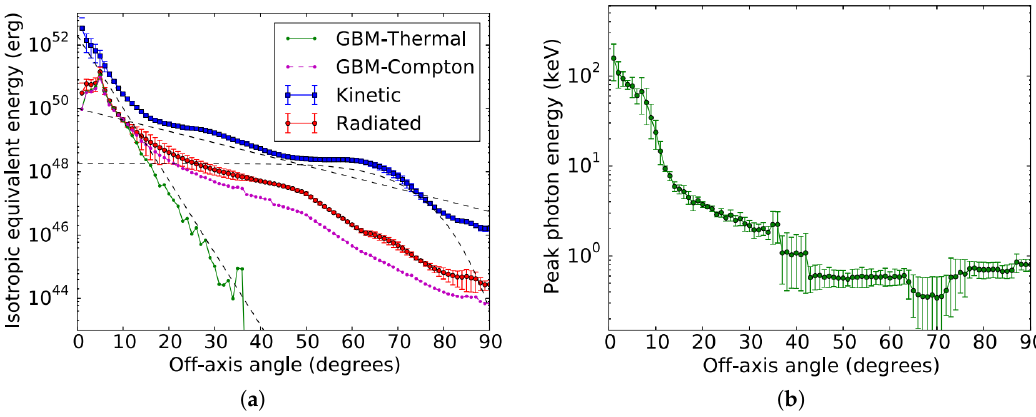
Figure 12. Both figures are taken from [209]. ( a ) Off-axis distribution of the isotropic equivalent energy. The error bars show the range of variation at each specific angle. The kinetic energy is shown in blue squares, while the bolometric energy is shown in red dots. The energy that Fermi (Gamma-ray Burst Monitor (GBM)) would detect is shown as lines with dots, green solid line is for a thermal spectrum and magenta dashed line for a Comptonized spectrum. The three components: the jet (exponential), the cocoon (exponential), and the shocked ambient medium (constant with sharp cutoff) are overlaid on the kinetic energy profile as black dashed lines. ( b ) Off-axis emission from the jet/cocoon photosphere. The peak photon energy is depicted, while the symbols are as defined above. (Reprinted from [209]. c (cid:13) AAS. Reproduced with permission).